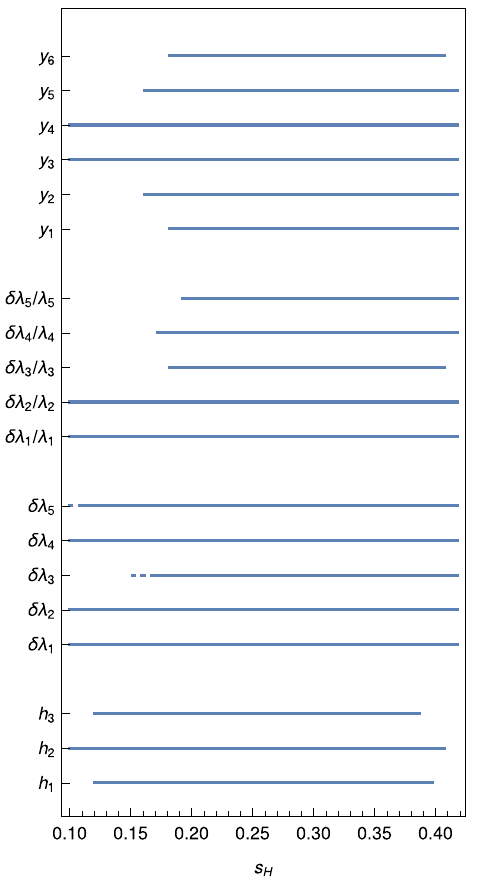
Fig. 4 Comparisonoftheperturbativitylimitsoftheparameterpointof Fig.2.Theleft-handsidecorrespondsto m H = 300GeV,theright-hand side to m H = 800 GeV. We show here the allowed parameter ranges which fulfil different sets of constraints. (i) h i : | ( m 2